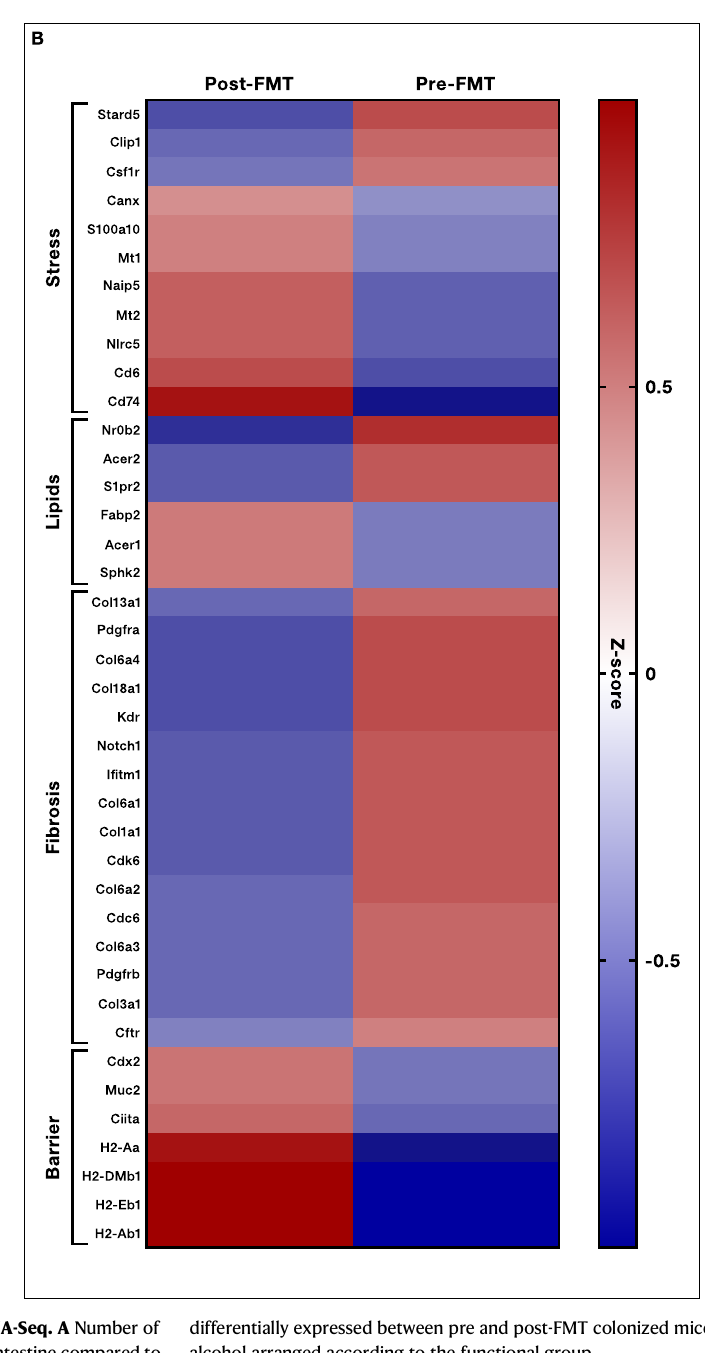
Fig. 9 | Differentially Expressed Genes (DEGs)on Tissue RNA-Seq. A Number of DEGs between pre and post-FMTmicewerehighest in small intestine compared to liver or prefrontal cortex (PFC). B Heatmap of relevant small intestinal genes